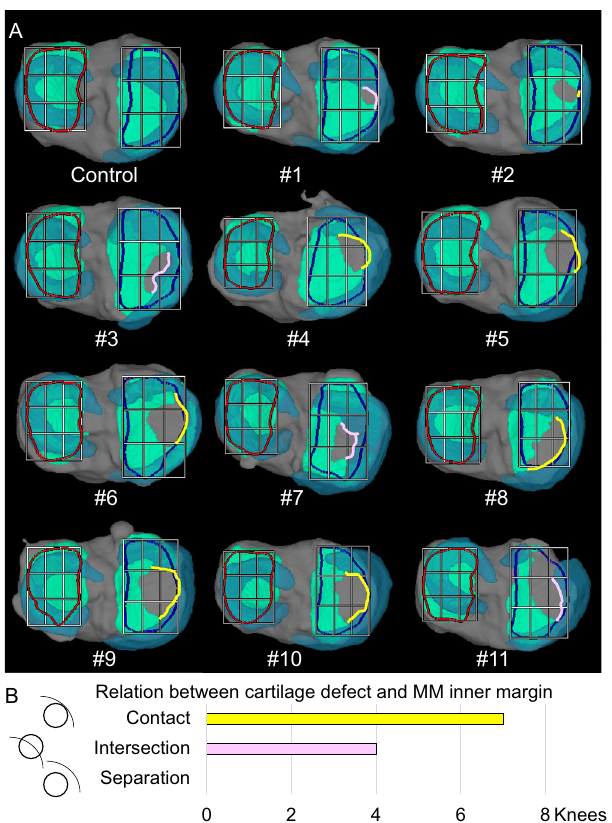
Figure 7. Relationship between cartilage defects and the inner margin of the medial meniscus (MM). ( A ) 3D MRI images of the articular surface of the tibia. The tibial cartilage is shown in green, the meniscus in translucent blue, and the bone in gray. The line where the inner margin of the MM contacts the cartilage defect is shown in yellow, and the line where the inner margin of the MM crosses the cartilage defect is shown in pink. ( B ) Quantitative evaluation of the relationship between cartilage defects and the inner margin of the